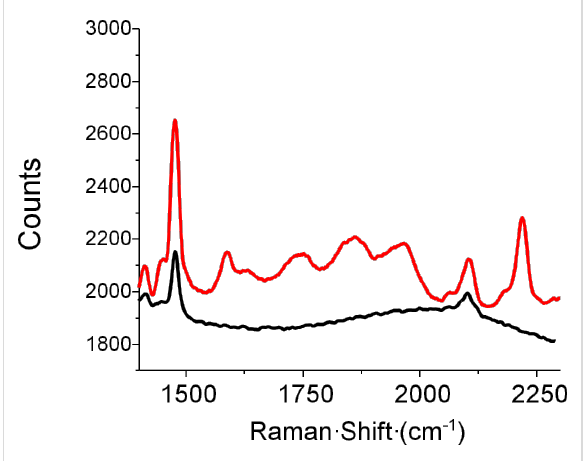
Figure 4: Background-corrected Raman spectra of PAM2 (red) and the blue material obtained after UV irradiation (black).